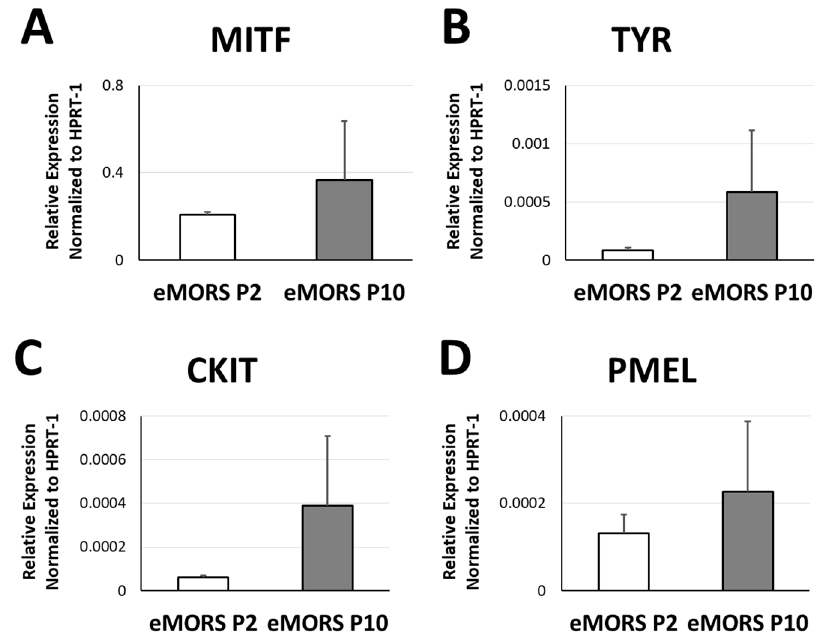
Figure 4. Gene expression of melanocyte markers in eMORS. qRT-PCR indicated gene expressions of ( A ) MITF, ( B ) TYR, ( C ) CKIT, ( D ) PMEL in eMORS at passage 2 and passage 10. Housekeeping gene HPRT-1 was used as the internal reference for each gene, and relative expressions are showed with mean ± SD.